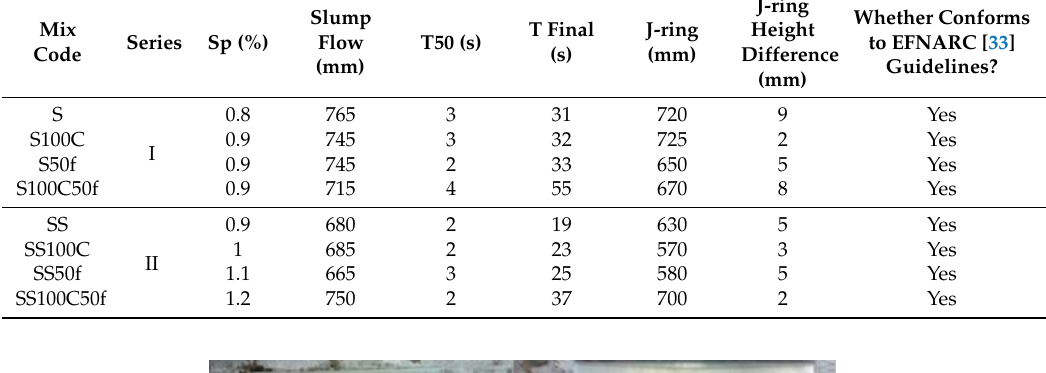
Figure 4. Concrete mixtures prepared with recycled aggregates: ( a ) concrete mixture without AEA and Sf; ( b ) concrete mixture with AEA; and ( c ) concrete mixture with Sf.